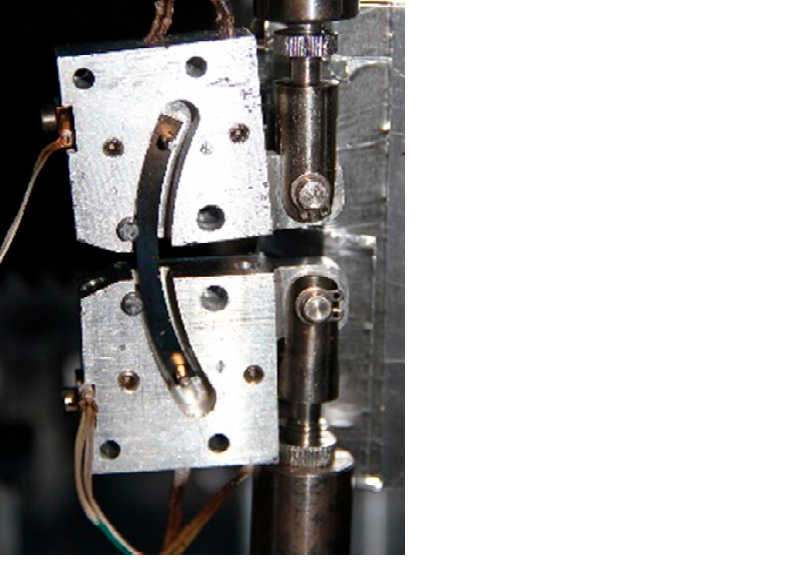
Figure 5. Sample holder constructed by CNEA, Buenos Aires, for a mechanical load machine to perform tensile tests at higher temperatures.